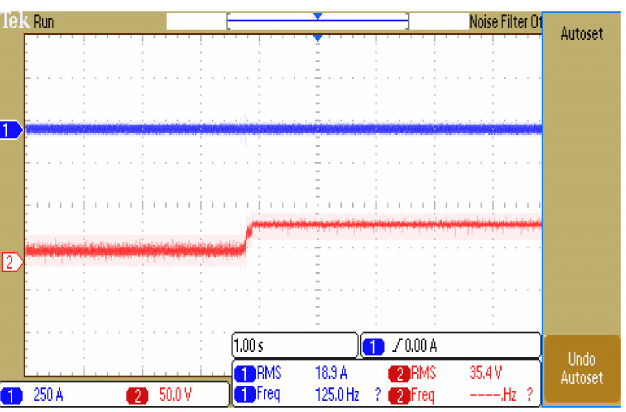
Figure 20. The output voltage waveform of load #1 after three loads are started at the same